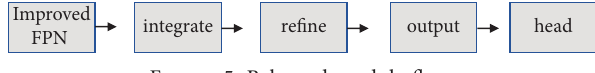
Figure 5: Balanced module